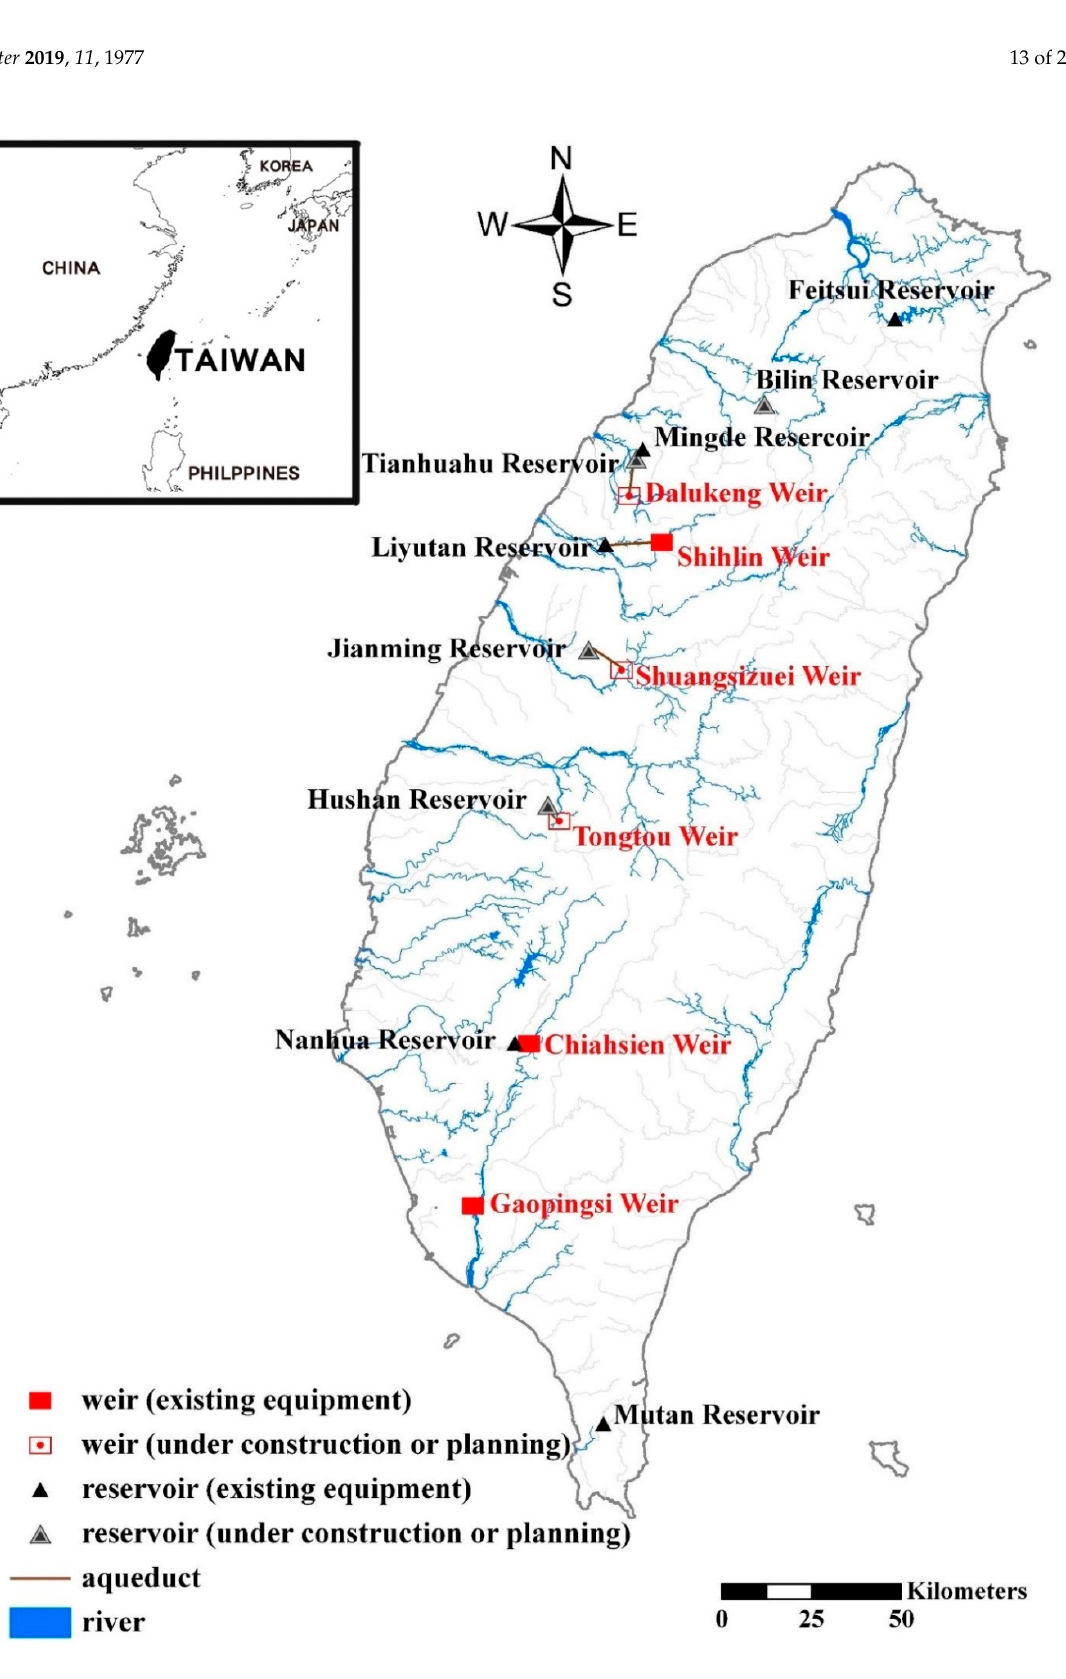
Figure 5. The location of selected cases.